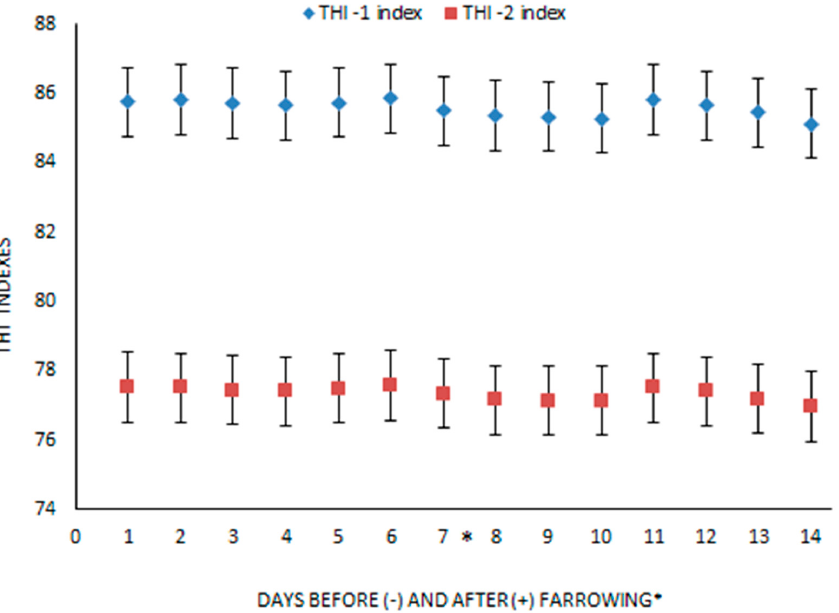
Figure 2. Mean daily value of THI-1 and THI-2 indexes and standard error (bars) 7 days before (-) and 7 days after (+) farrowing (*).